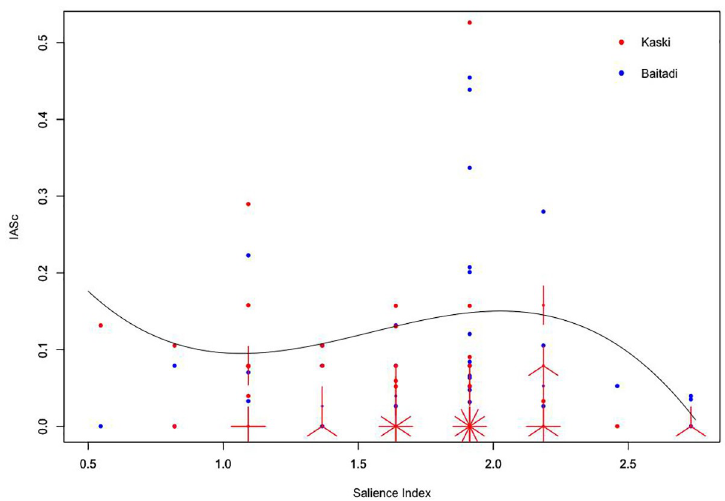
Fig 3. Regression of plant use knowledge consensus (IASc) of participants along the gradients of plant salience